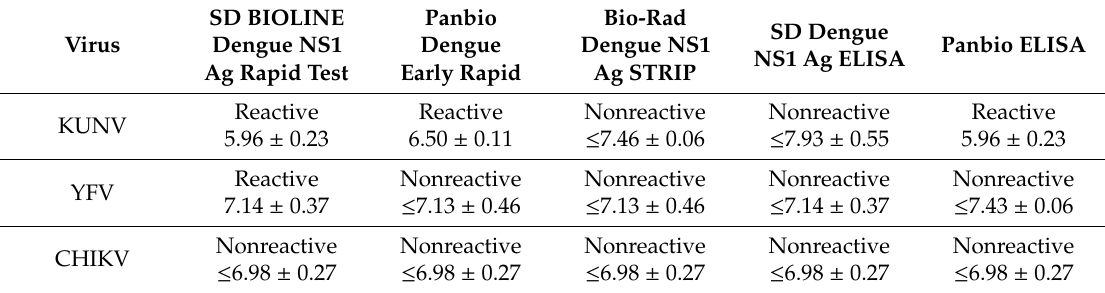
Table 3. Detection of KUNV, YFV and CHIKV for Dengue NS1 Ag rapid assays and Dengue NS1 ELISAs.